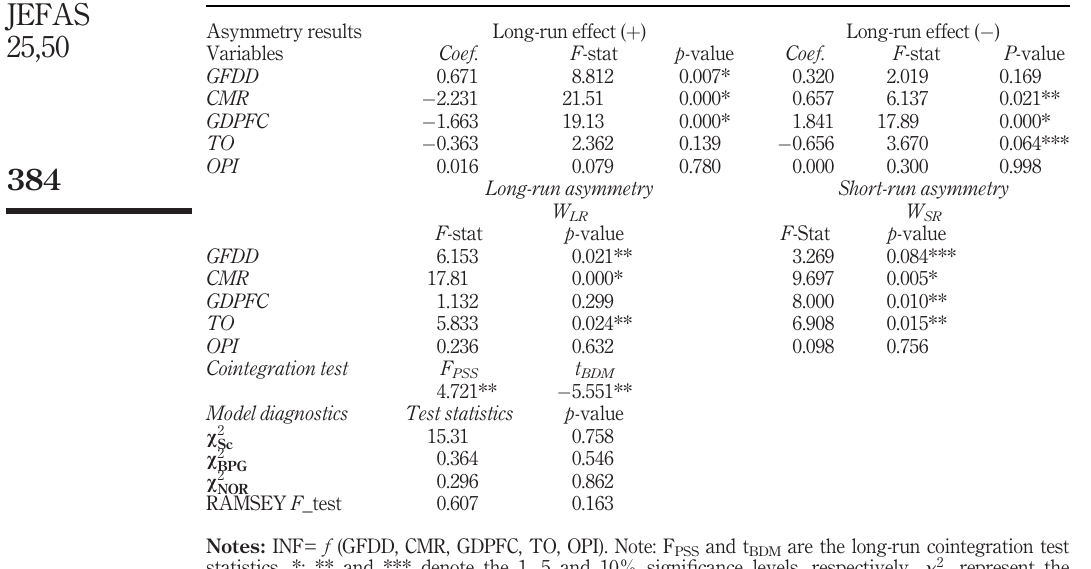
Table 6. Long and short-run asymmetry results (Model